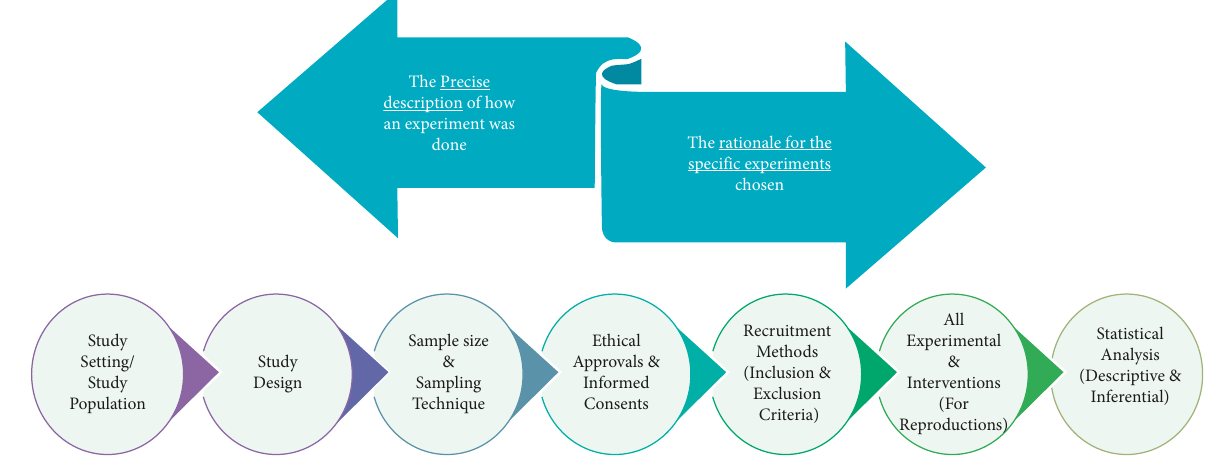
Figure 7: Methods and the seven areas which it should exhaustively Table 2: Different guidelines available for perusal of the authors for writing an effective manuscript. Guideline